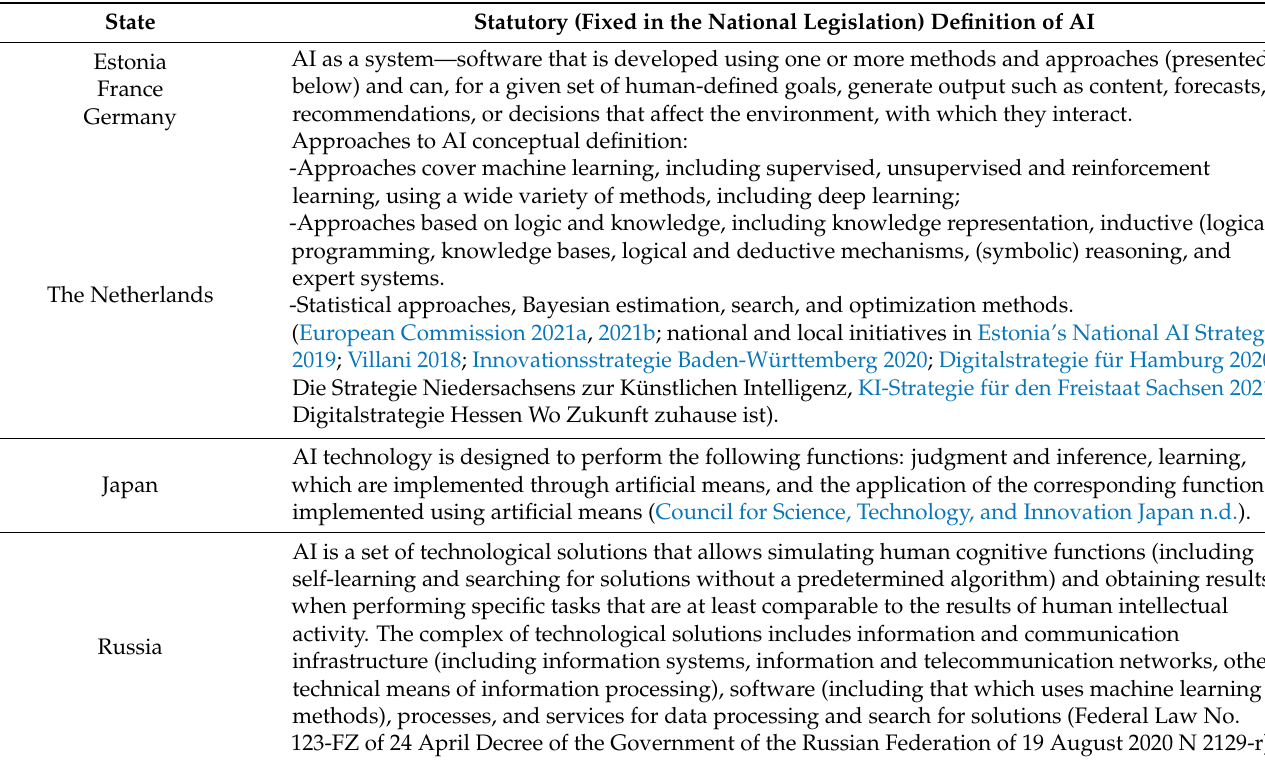
Table 2. Comparative analysis of fixed legislative approaches in the leading countries of the Ro-mano- Germanic legal system regarding the AI definition (compiled by the